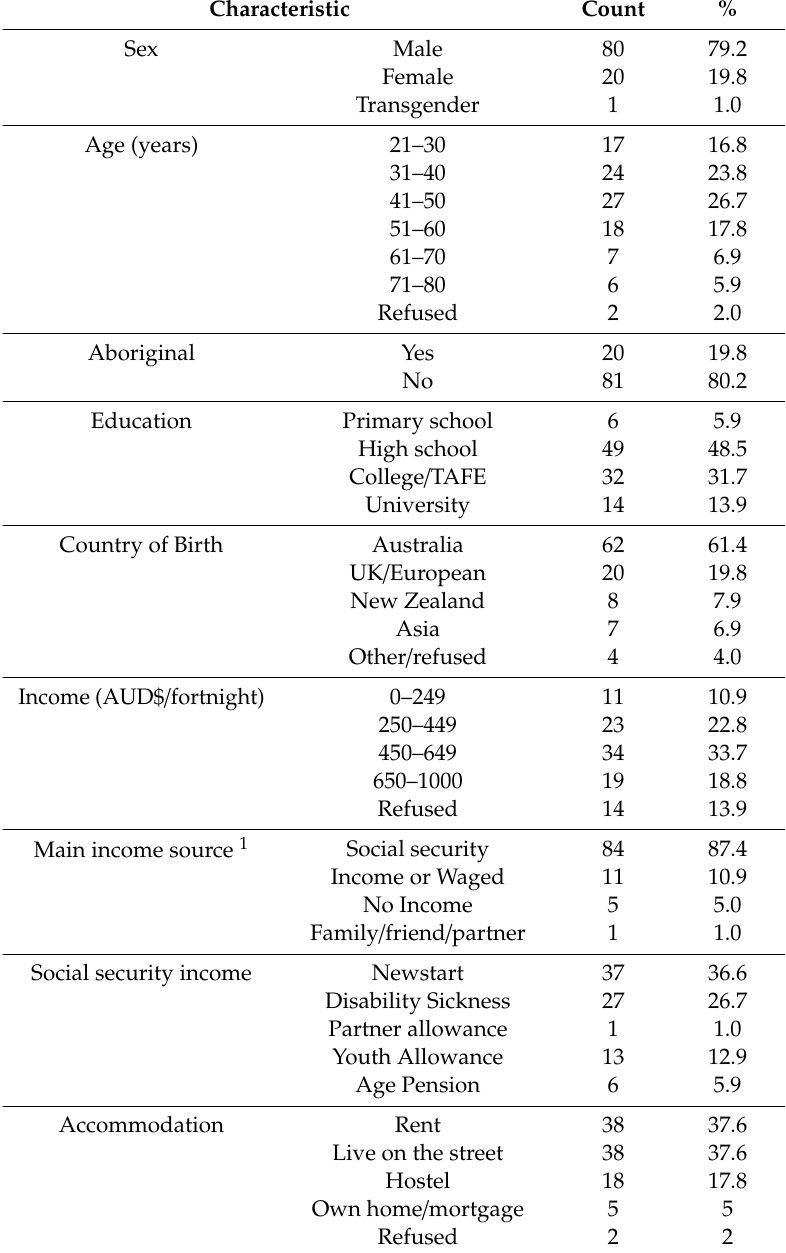
Table 1. Demographic characteristics of direct service recipients’ of Charitable Food Services in Inner City Perth, Western Australia (WA), January 2016 ( n =